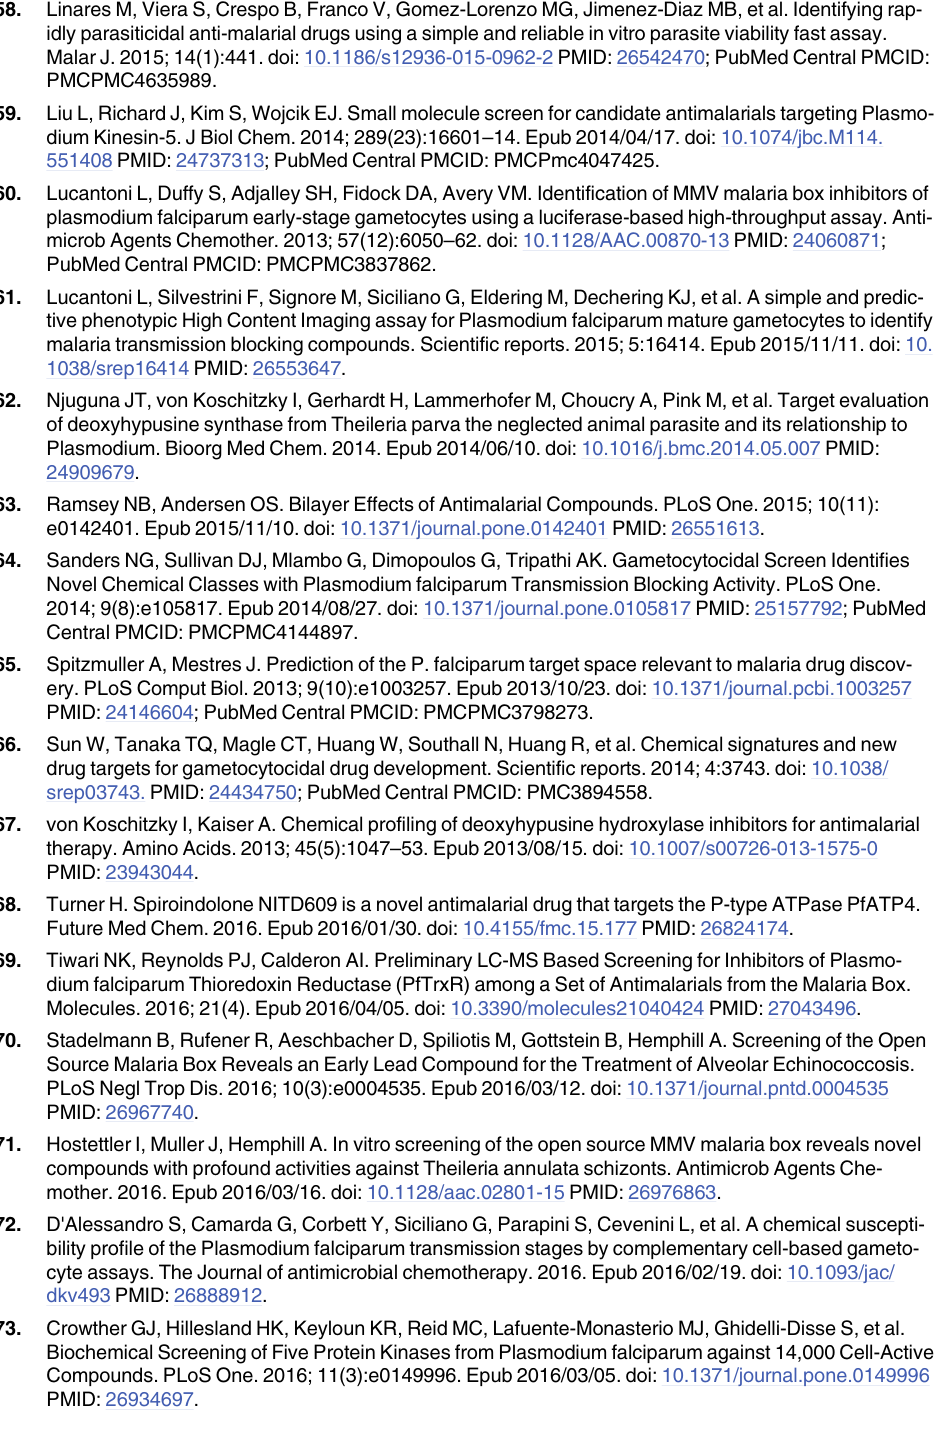
PLOS Pathogens | DOI:10.1371/journal.ppat.1005763 July 28,